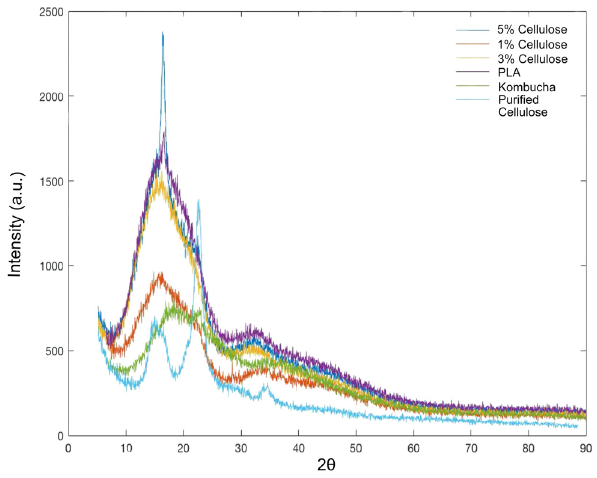
Figure 5: X - ray di ff raction patterns of PLA – cellulose blends and neat materials.